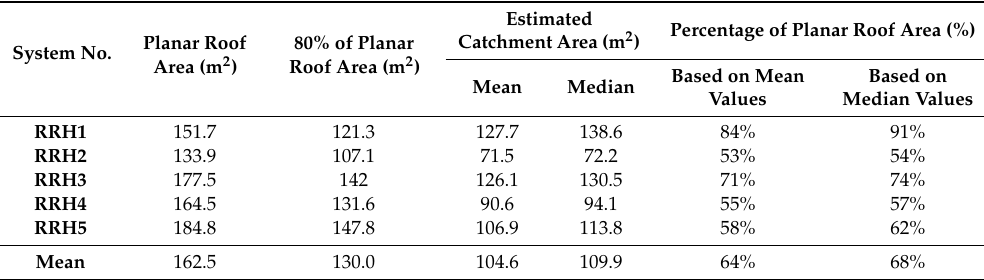
Table 5. Planar and estimated roof